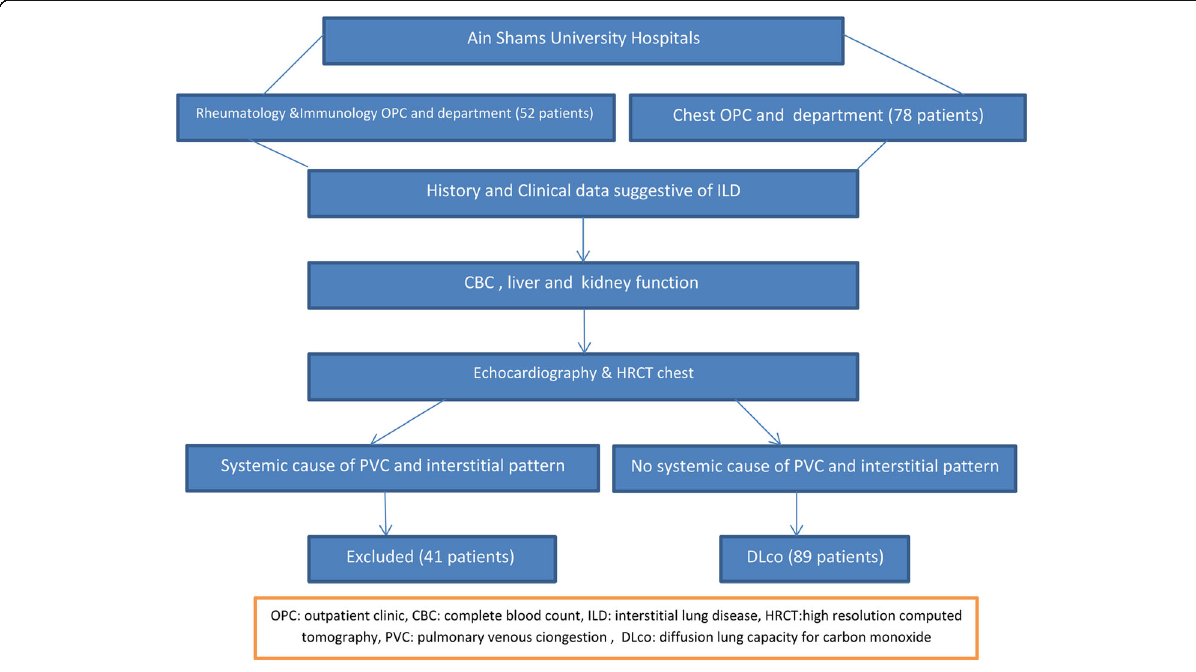
Fig. 1 Flow chart for patient